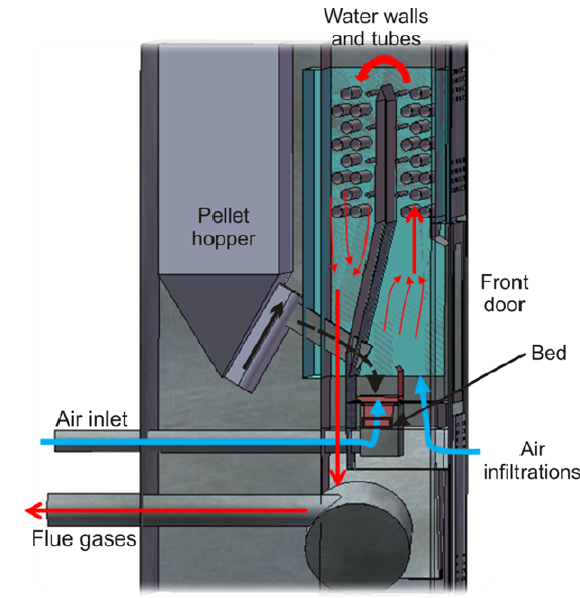
Figure 1. Schematic of the